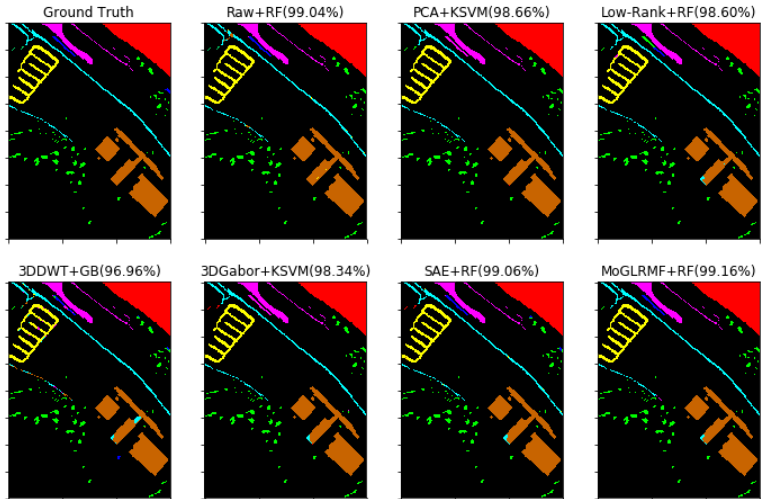
Figure 4. Classification maps of different methods on Pavia Center dataset (1% proportion training samples for each class).